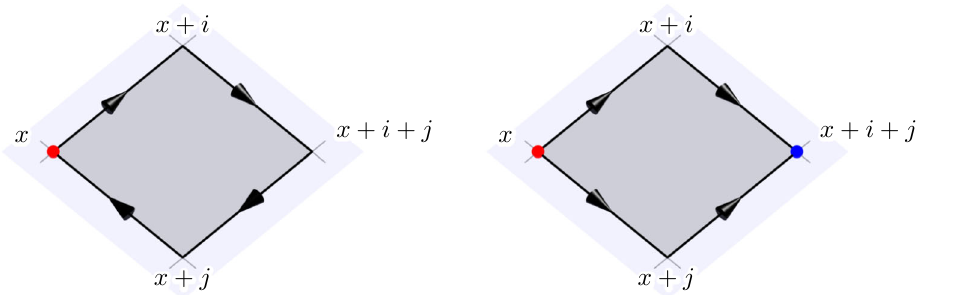
andendsatthesamelatticesite x (reddot),thelatticefield-strength C x , ij starts at x and ends at x + i + j (blue